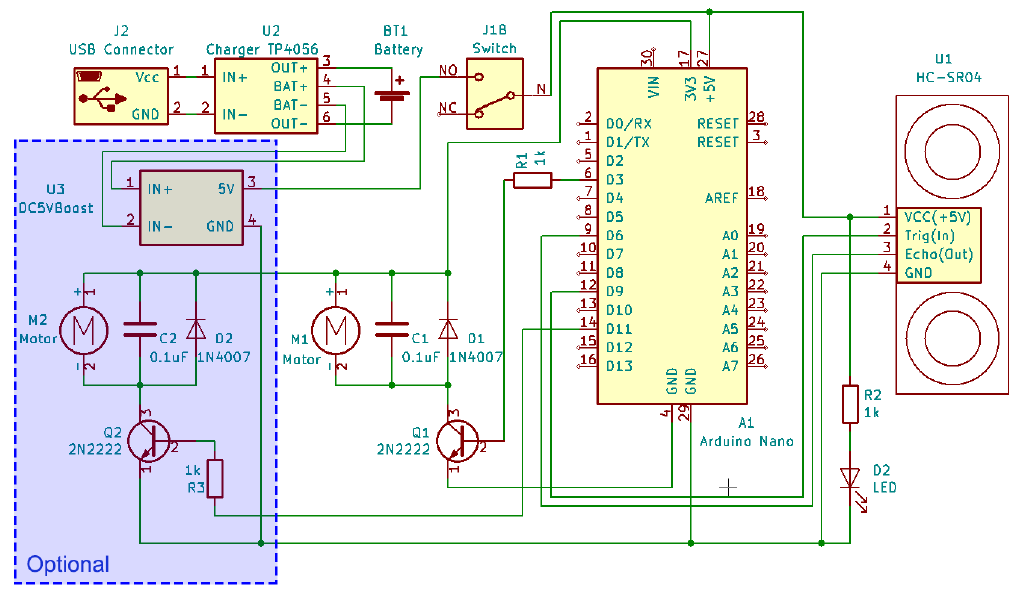
Figure 2. Electrical circuit.